Question: Provide a one-line summary of what is displayed.
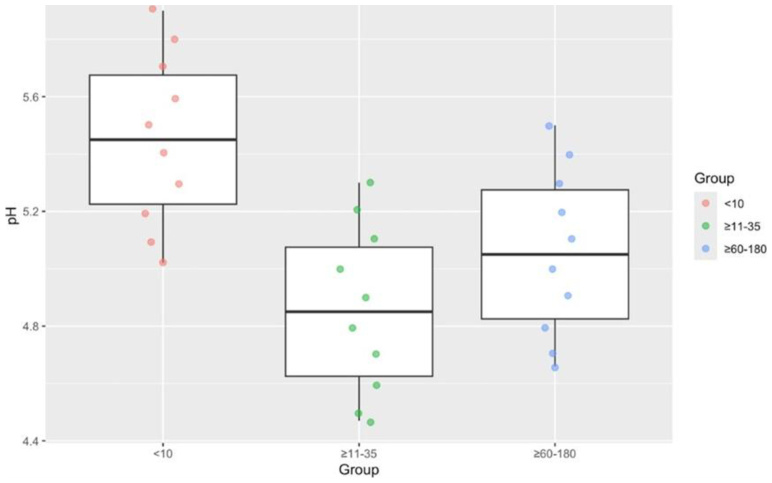
Answer: Boxplot analysis of epidermal pH among 3 groups.